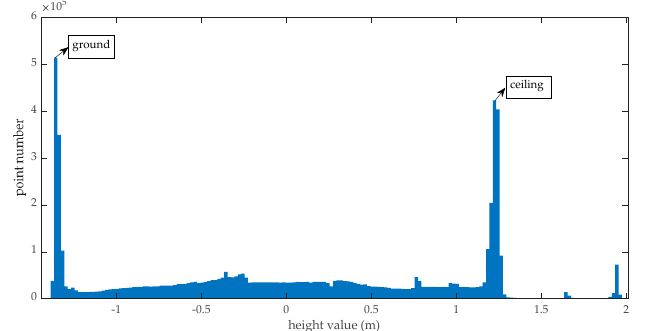
Figure 3. The height histogram of a station indoor point cloud.